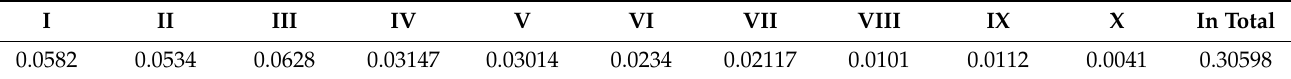
Table A8. Results by items (B&PP